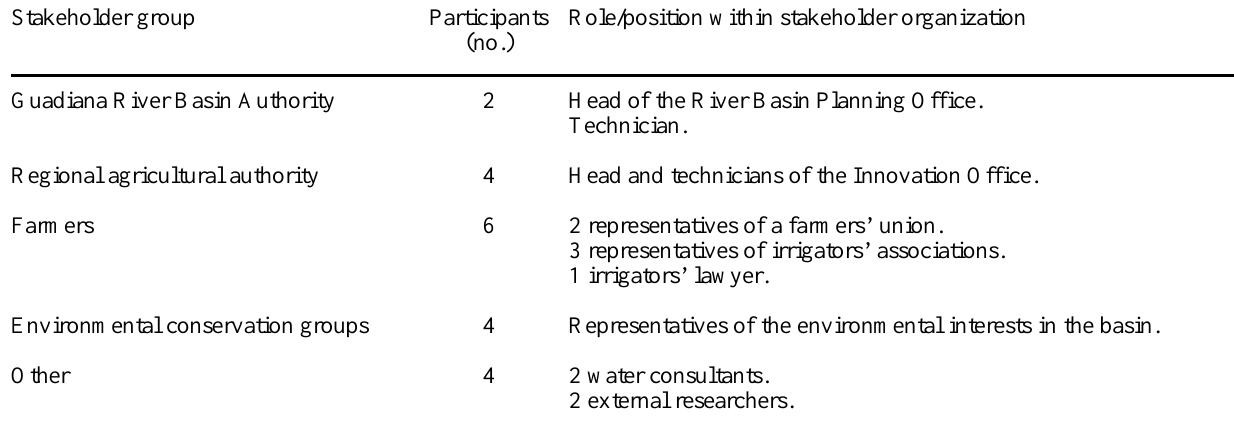
Table 1 . Participants. Stakeholder